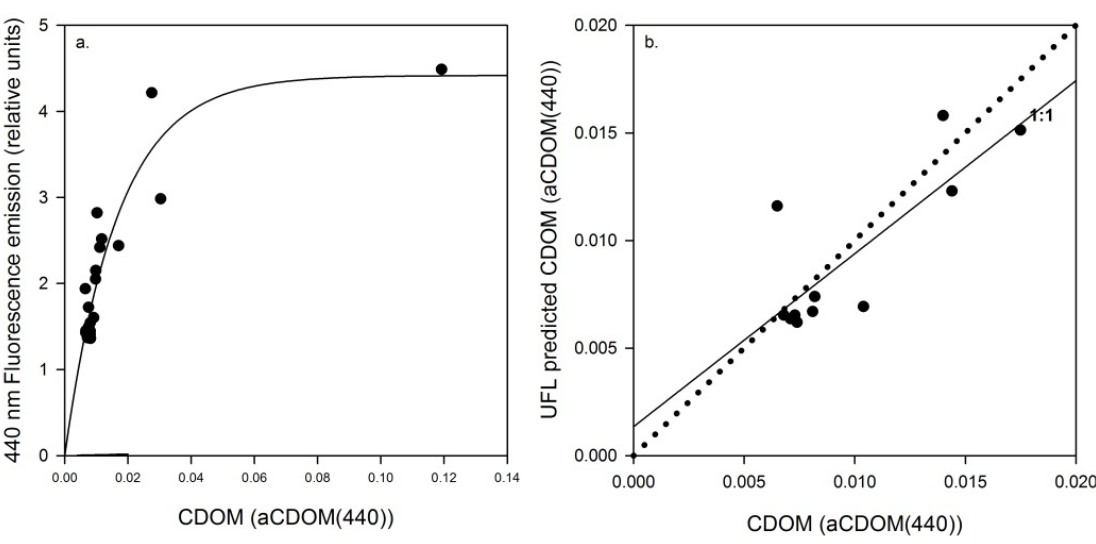
+ 19.50; R = 0.85; 355